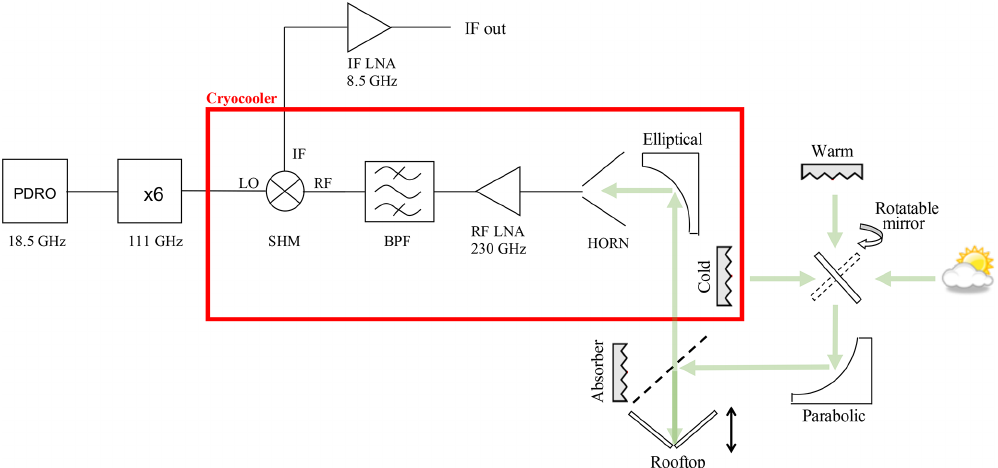
Figure 1. Schematic of the CORAM receiver and simplified version of the quasioptics. A rotatable mirror selects a signal from either the atmosphere, warm target, or cold target. The signal is directed by a parabolic mirror to a path length modulator that is comprised of a polarising wire grid, an absorber, and an oscillating rooftop mirror. The signal passes through a window in the cryocooler, where it is directed to the receiver with an elliptical mirror. The signal enters the corrugated feed horn and encounters the radio frequency (RF) LNA, a waveguide filter (BPF), and a sub-harmonic mixer (SHM). At the SHM the signal is down-converted to an intermediate frequency (IF) of 8.5GHz. The IF signal exits the cryocooler and passes through a room temperature LNA. The RF (atmospheric) signal is mixed at the SHM with a local oscillator (LO), which is an 18.5GHz signal from a phase-locked dielectric resonator oscillator (PDRO) that is passed through a 6x frequency multiplier, to provide 111GHz. The IF out signal will be further down-converted to 0.5GHz before being analysed by a fast Fourier transform spectrometer (not shown here). Further details on quasioptical components can be found in Goldsmith (1998).